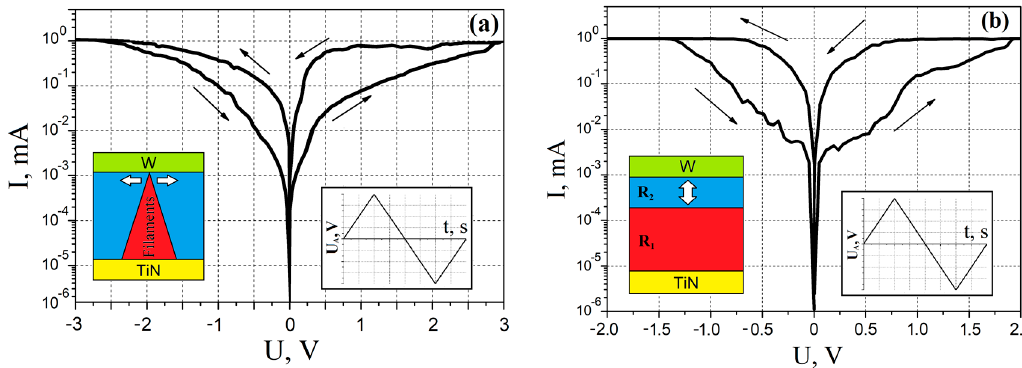
Figure 7. I–V characteristics of nanocrystalline ZnO films: ( a )—without annealing (25 °C) and ( b )— after annealing at 1200 °C .